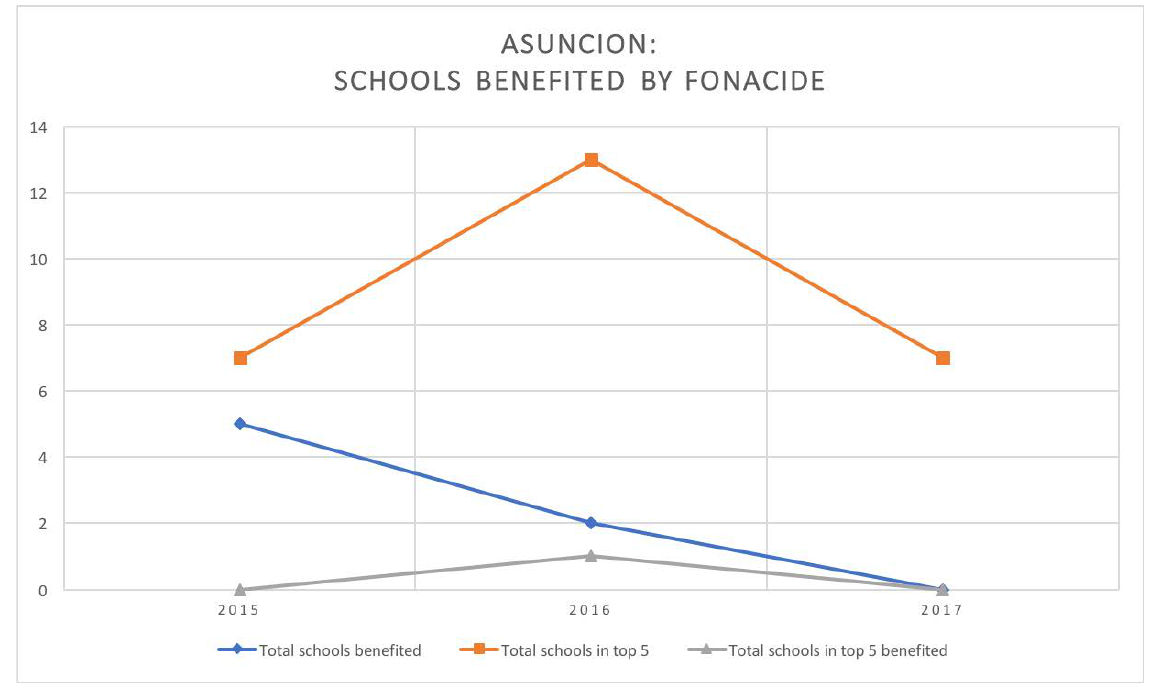
Figure 8: Asuncion: Schools Benefited by FONACIDE